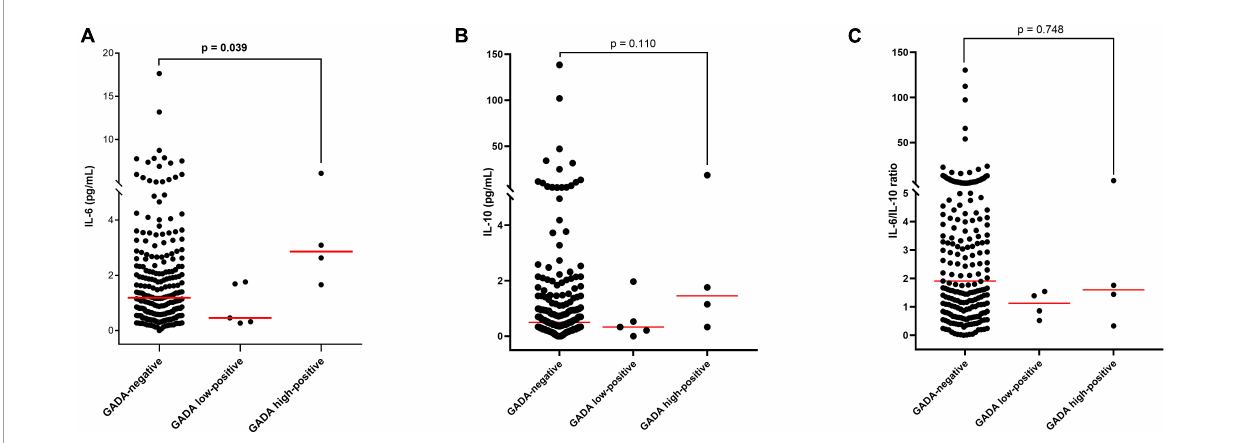
FIGURE1 Distribution and median concentrations of IL-6 and IL-10 levels and their ratio in different study groups: (A) IL-6 levels, (B) IL-10 levels, and (C) the IL-6/IL-10 ratio.